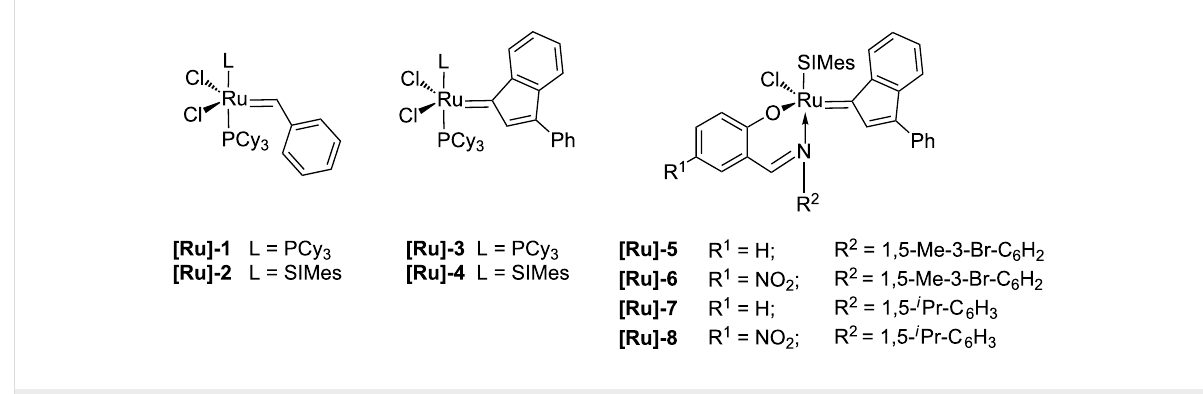
Figure 1: The ruthenium metathesis catalysts used. (SIMes: 1,3-bis-(2,4,6-trimethylphenyl)-4,5-dihydroimidazol-2-ylidene).